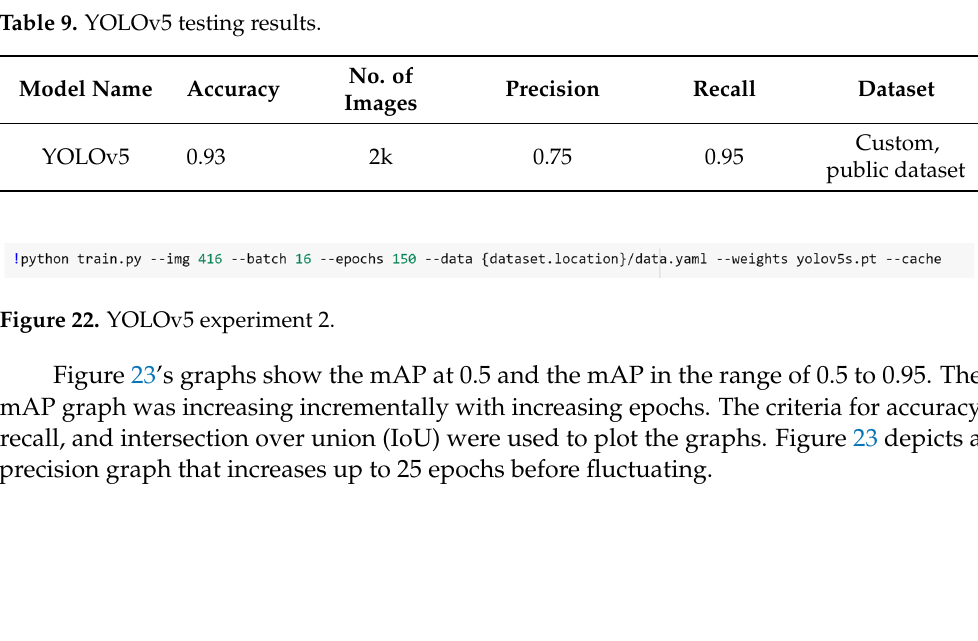
Table 9. YOLOv5 testing results.